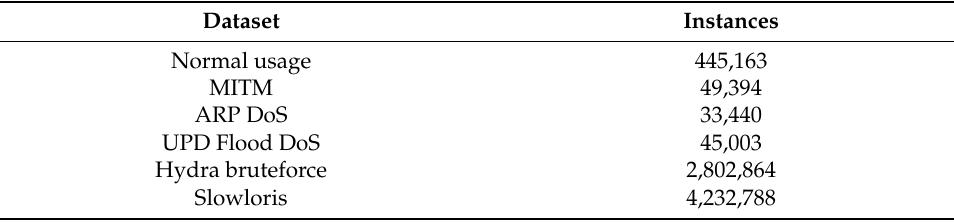
Table 1. Total instances for different attacks and normal usage.